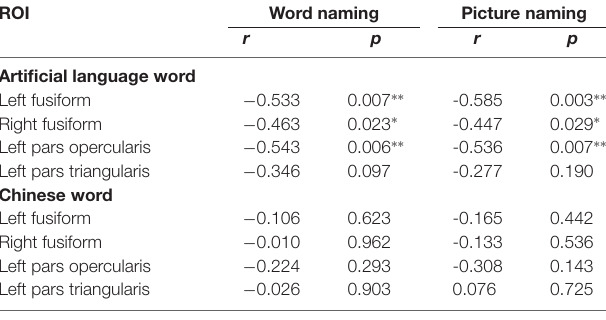
TABLE 2 | Correlations between pattern similarity at Day 4 and Day 12 and RT in the two naming tasks ( ∗ p < 0.05). ROI Word naming Picture naming